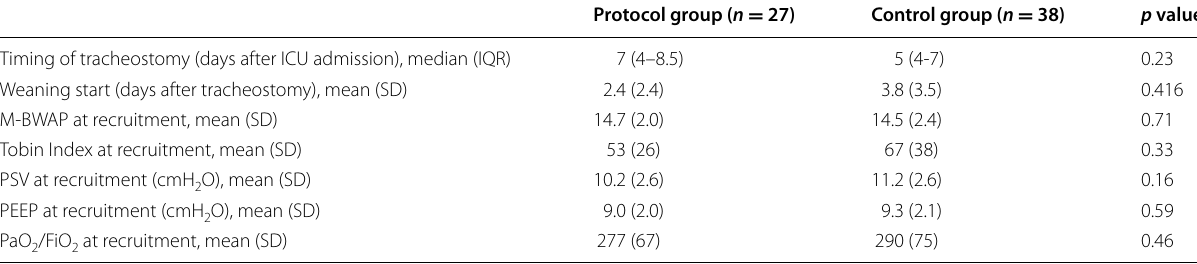
Table 3 Measured parameters of the mechanical ventilation and weaning